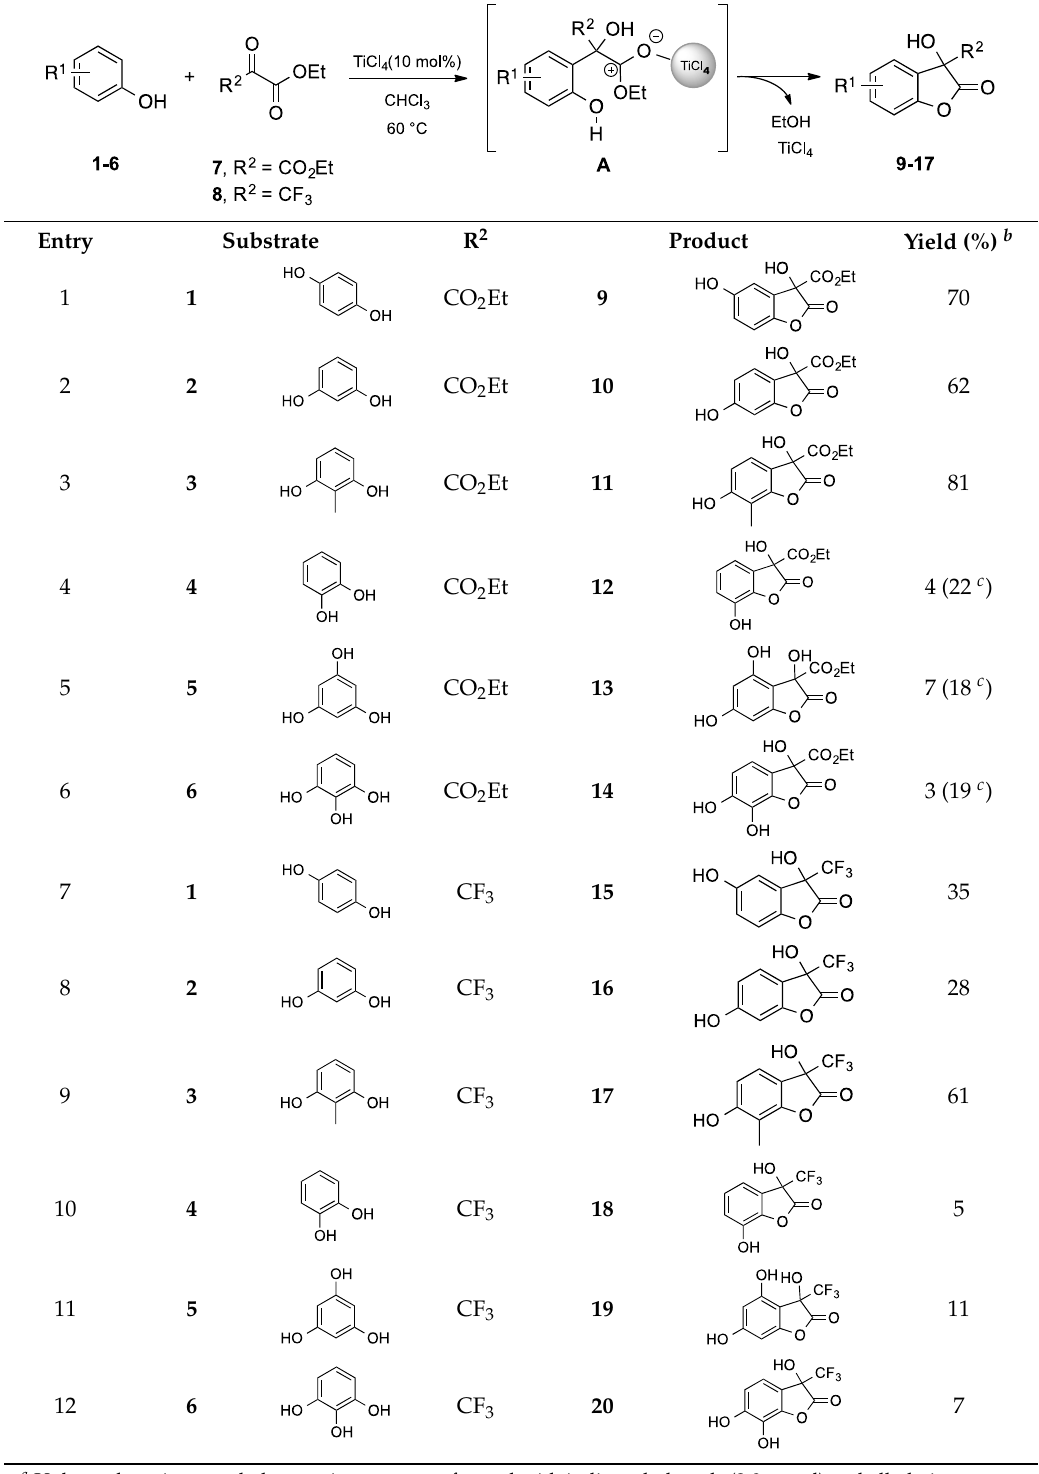
Table 1. Friedel–Crafts alkylation/lactonization of polyphenols 1–6 performed with TiCl 4 as catalyst a .